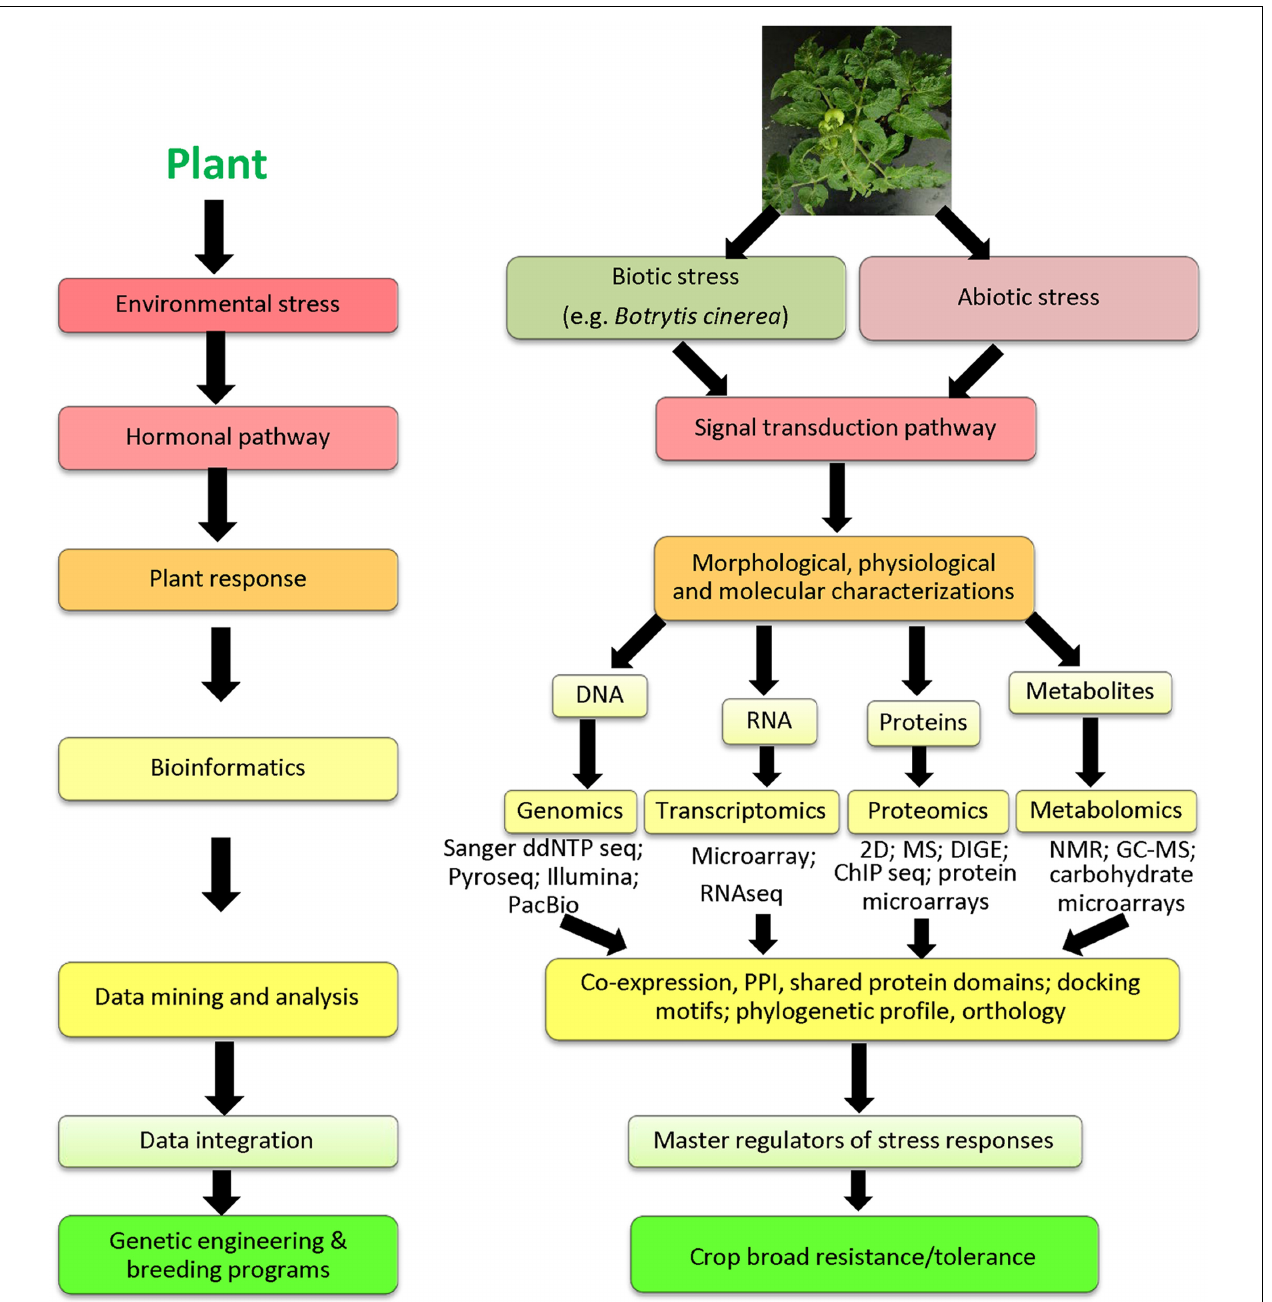
FIGURE 1 | Schematic representation of omic approaches used in improvement of plant resistance/tolerance to biotic and abiotic stresses. Sanger ddNTP seq, Sanger dideoxy nucleotide; Pyroseq, pyrosequencing; Illumina, Illumina sequencing; PacBio, Pacific Biosciences; RNAseq, RNA sequencing; ChIP seq, chromatin immunoprecipitation sequencing; 2D, 2-dimensional gel electrophoresis; DIGE, differential gel electrophoresis; MS, mass spectrometry; NMR, nuclear magnetic resonance; GC-MS, gas chromatography-mass spectrometry; PPI, protein-protein interaction.